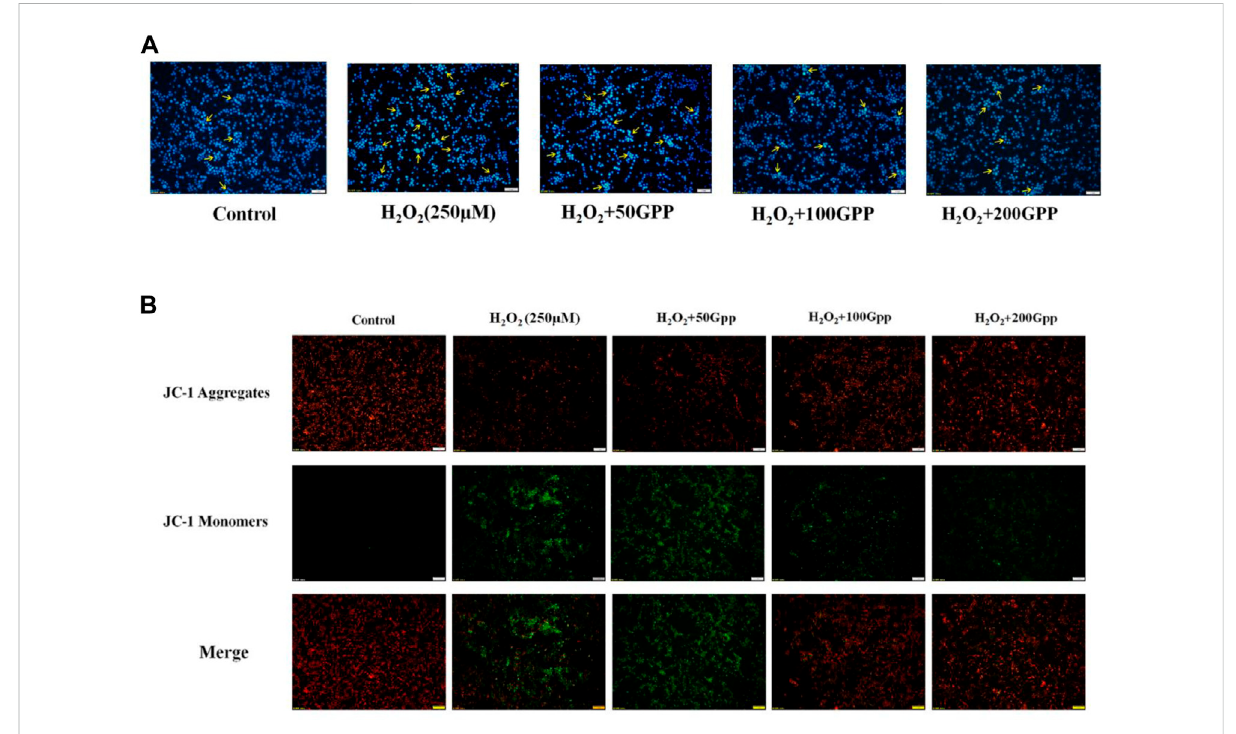
Figure 8A, the apoptosis rate in the control group was 6.48 ± 0.58% of the total cells. However, the apoptosis rate in the H 2 O 2